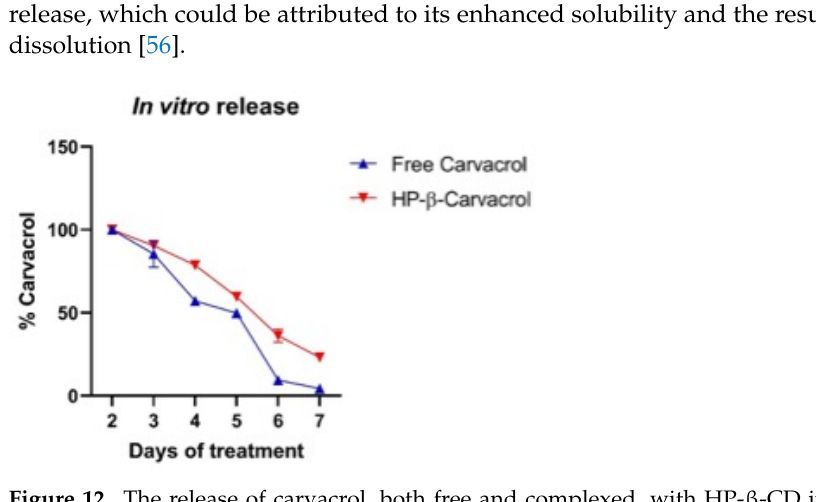
Figure 12. The release of carvacrol, both free and complexed, with HP- β -CD in the presence of HCT- 116 cells, at 37 °C, after 7 days of treatment, where n = 3.